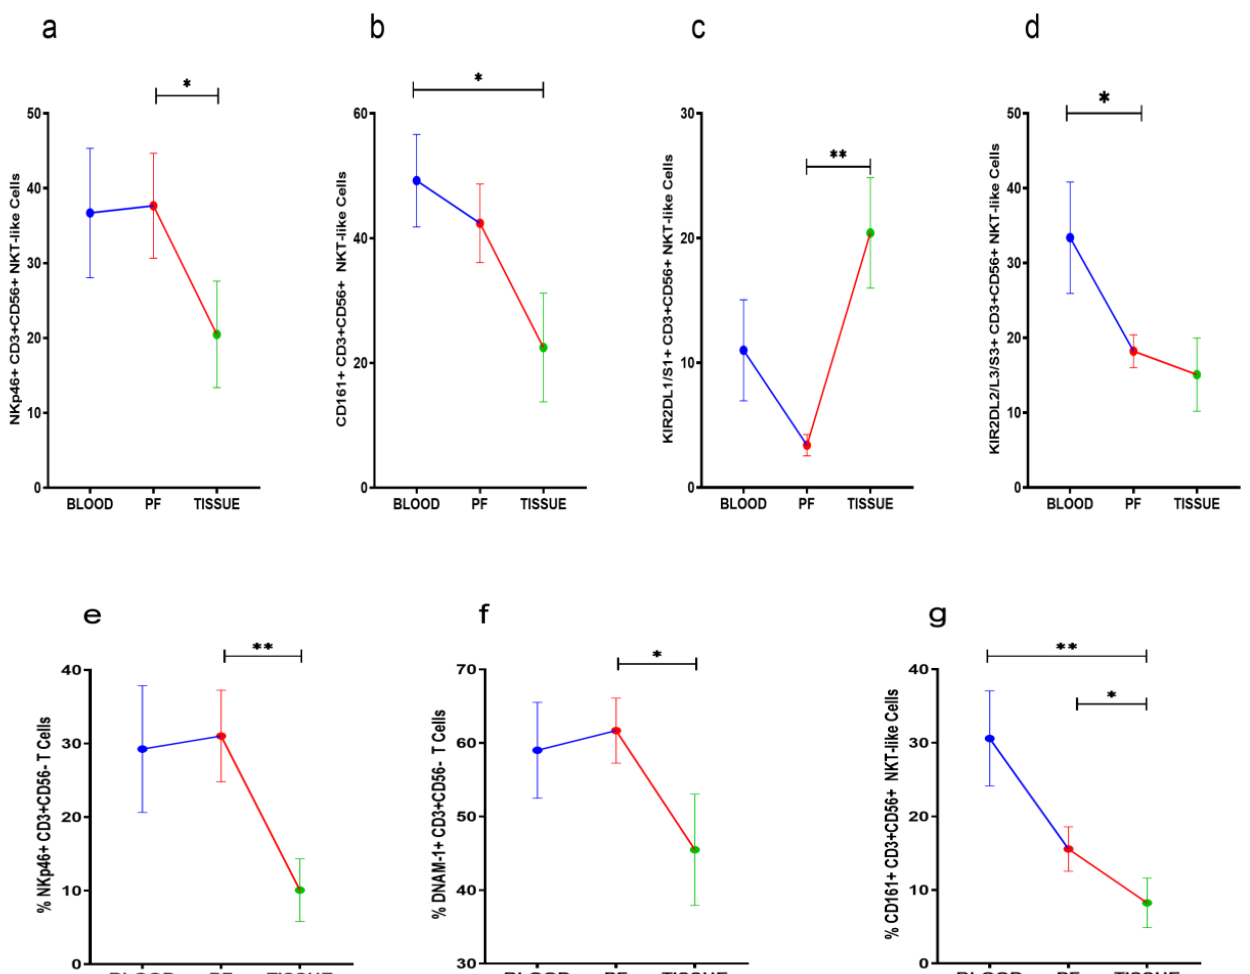
Figure 4. Wilcoxon matched-pairs signed ranked test ( a – d ) for receptor expression of NKT-like cells and ( e – g ) for receptor expression profile of T cells in peripheral blood, peritoneal fluid (PF), and tissue specimens * p < 0.05; ** p < 0.01.